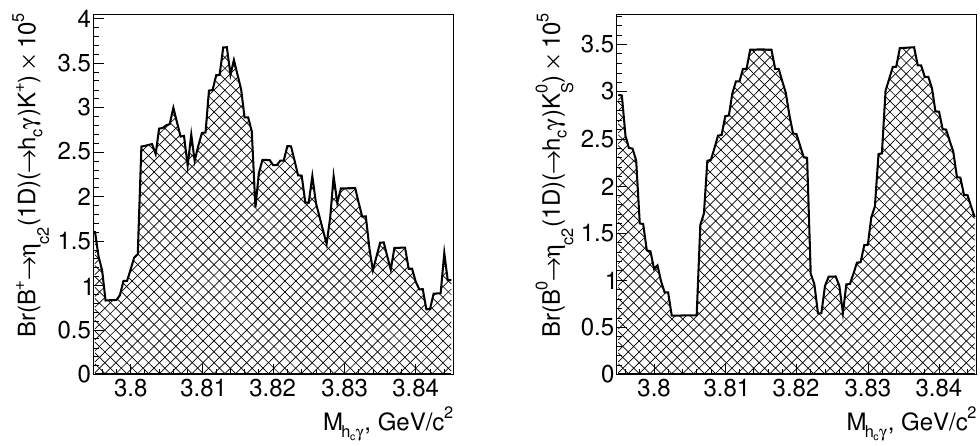
Figure 7 . Con(cid:12)dence intervals (90% C.L.) for the branching-fraction products for the channels B + (cid:17) c 2 (1 D ) K + (left) and B 0 !